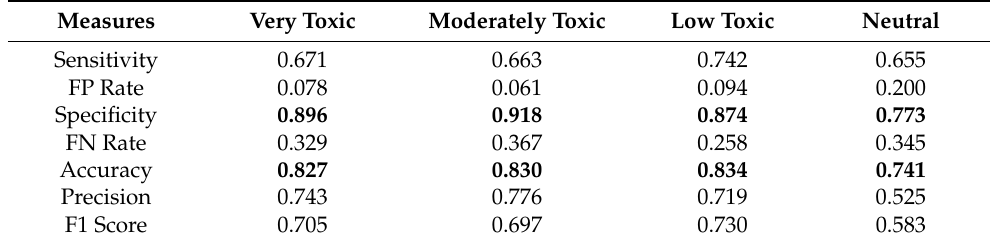
Table 2. Effectivity of Naïve Bayes Multinomial Text model for recognition of four degrees of toxicity in online discussions.